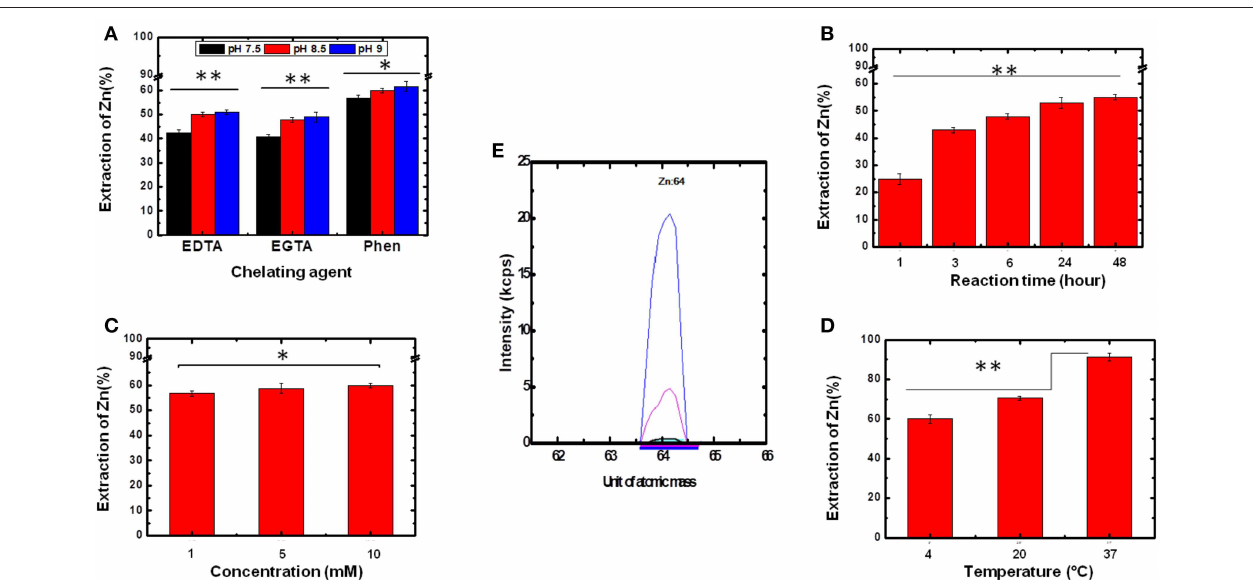
FIGURE 4 | Determination of the optimum conditions for Zn removal. To determine the best experimental parameters for the removal of bound Zn, several conditions were tested. Statistical analyses were performed using ANOVA and considered significant for * p > 0.05 and ** p < 0.05. (A) Chelating agent and pH. (B) Reaction time. (C) Chelating agent concentration. (D) Temperature. (E) ICP-MS spectra of purified Ydj1 before (blue) and after (red) the use of the best conditions for Zn removal (see text for details). Blank control